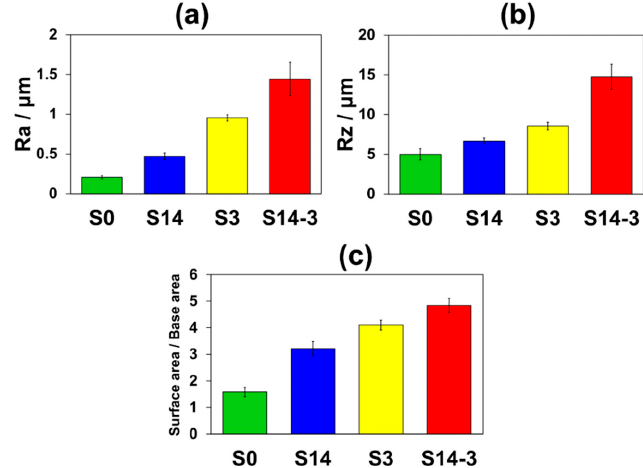
Figure 5. ( a ) R a and ( b ) R z in surface roughness and ( c ) values obtained by dividing surface areas by base areas for S0, S14, S3 and S14-3. Error bars show the standard deviations.